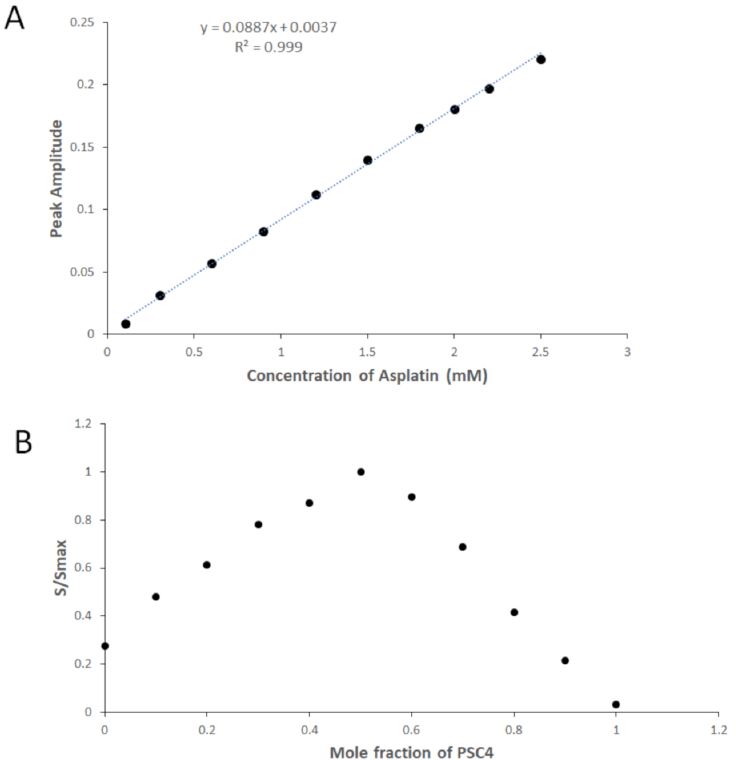
Figure 3. ( A ) Absorbance spectra of 0.2 mM PSC4 and various mixtures comprised consecutively of increasing concentrations of asplatin (ranging from 0.00–0.25 mM) and a fixed concentration of 0.2 mM PSC4 all in aqueous media. ( B ) Normalized Job’s plot for asplatin/PSC4 inclusion complex. Measurements were carried out in